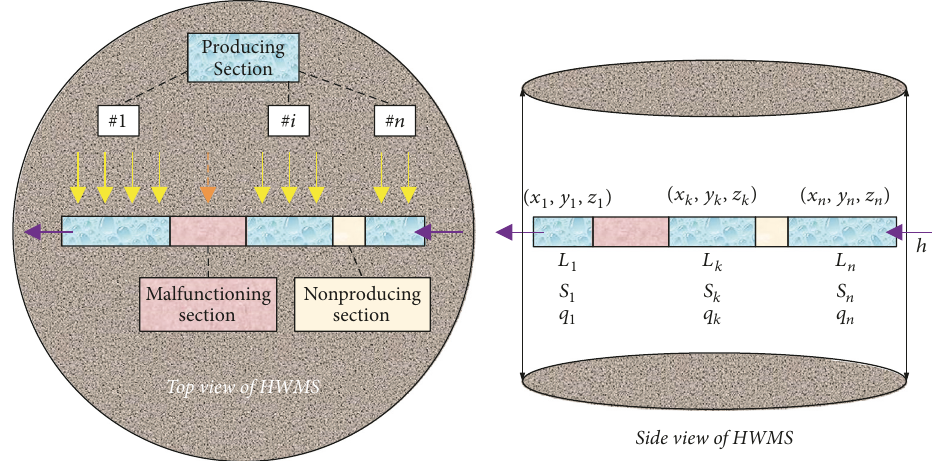
Figure 1: Physical model of HWMS (top view and side